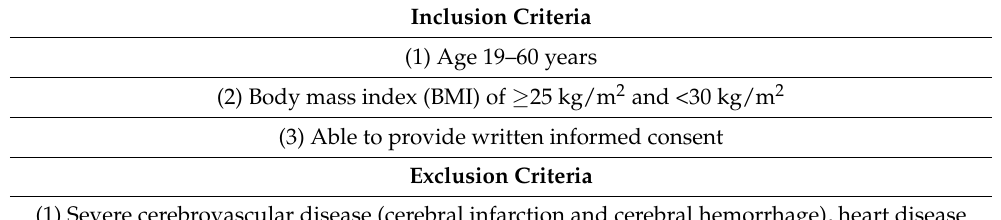
Table 1. Participant selection